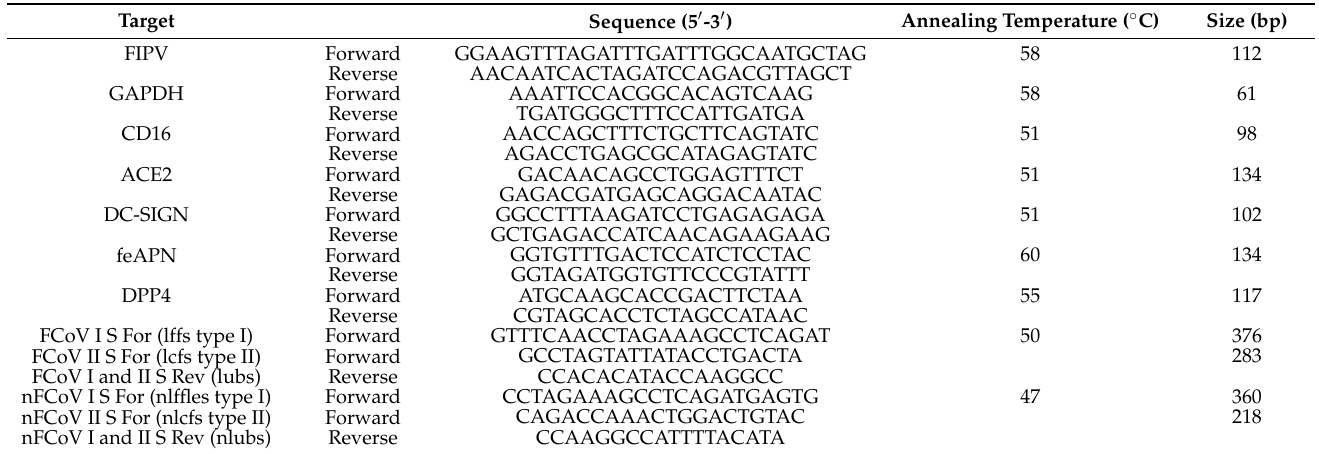
Table 2. Primers utilized in all PCR reactions with annealing temperatures and expected amplicon sizes for each primer